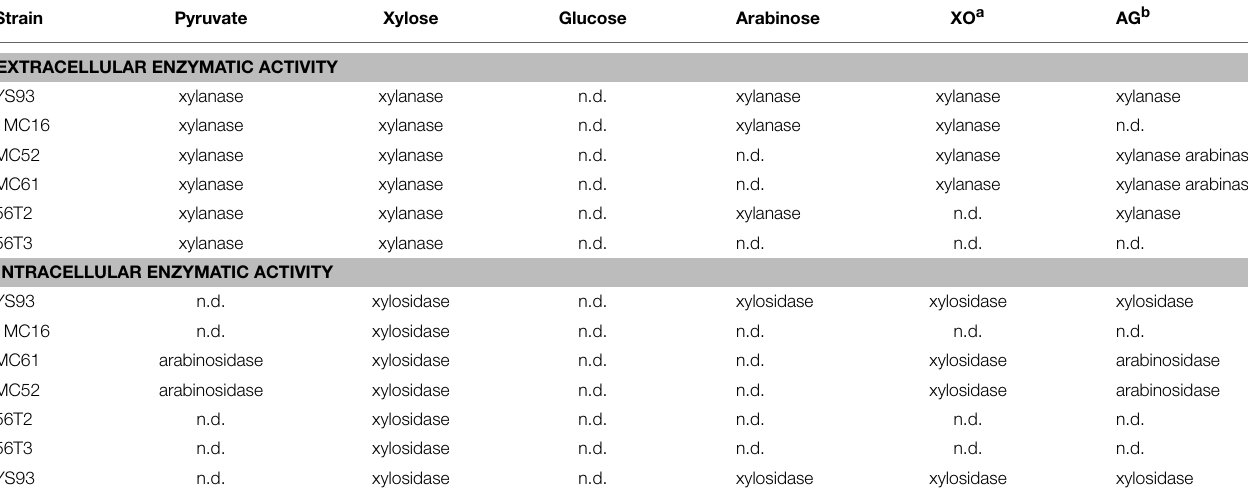
TABLE 2 | Enzymatic activities of Geobacillus strains grown on various carbohydrate substrates. Strain EXTRACELLULAR ENZYMATIC